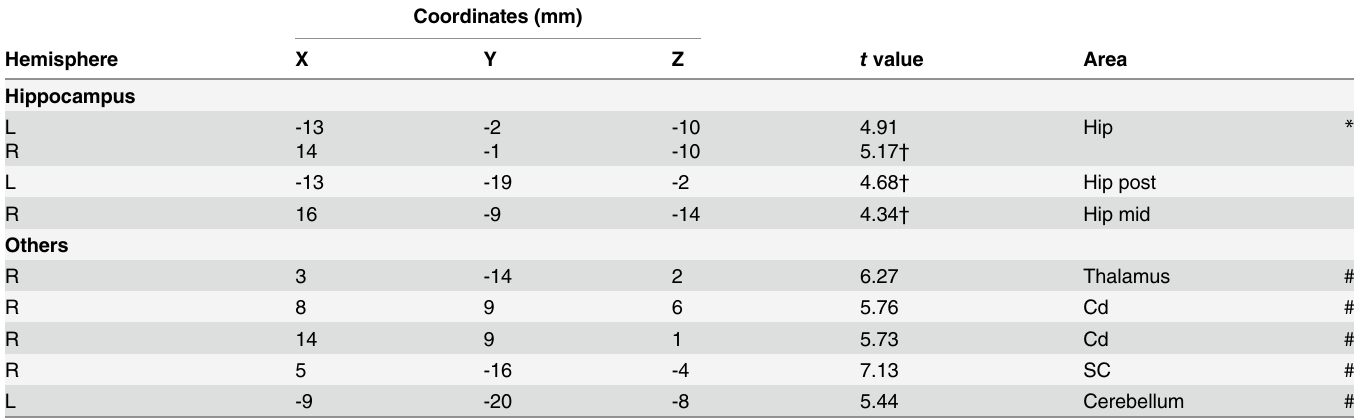
p = 0.01 for betweenness centrality, randomization test) (S8 Fig). Even without any assump- tions of directionality in PPI, the betweenness centrality of area 9/46d was confirmed to be